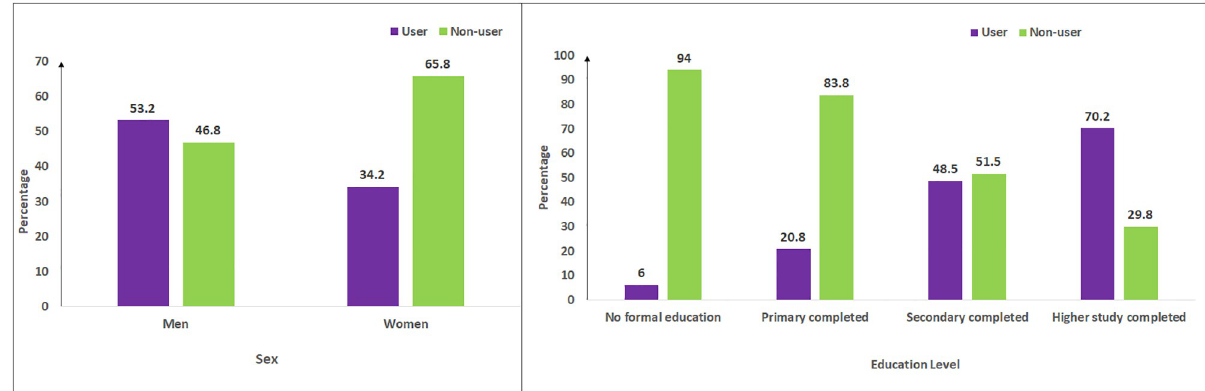
Fig 2. The distribution of internet users and non-users in Bangladesh across sex and education levels (Source: Bangladesh National ICT Household Survey [20]).